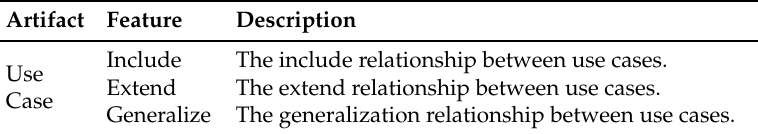
Table 4. The relationship feature of use case in phase